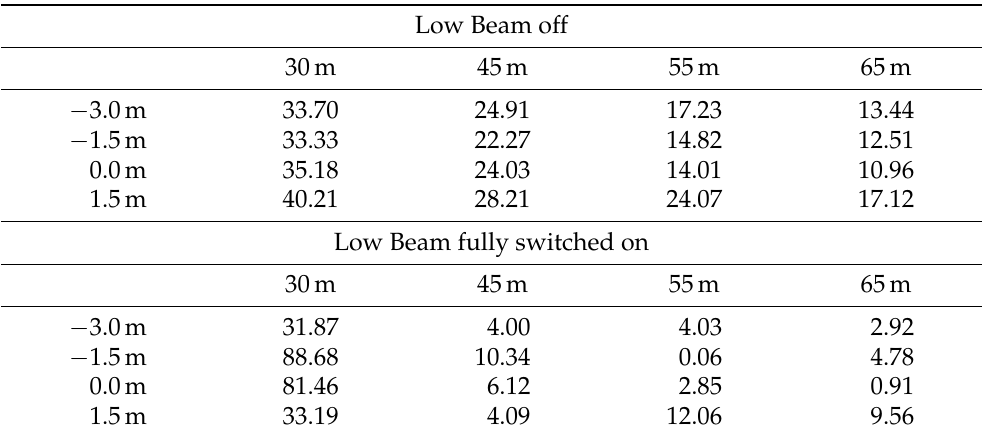
Table 2. Calculated Visibility Levels for test road 1, vehicle position 1.